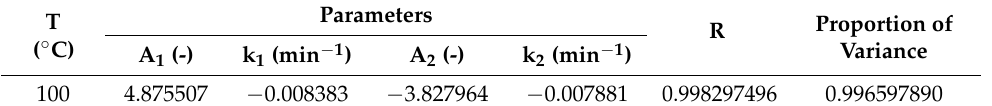
Table 1. Parameters of Equation (65) obtained after fitting to experimental data of average moisture content [8].